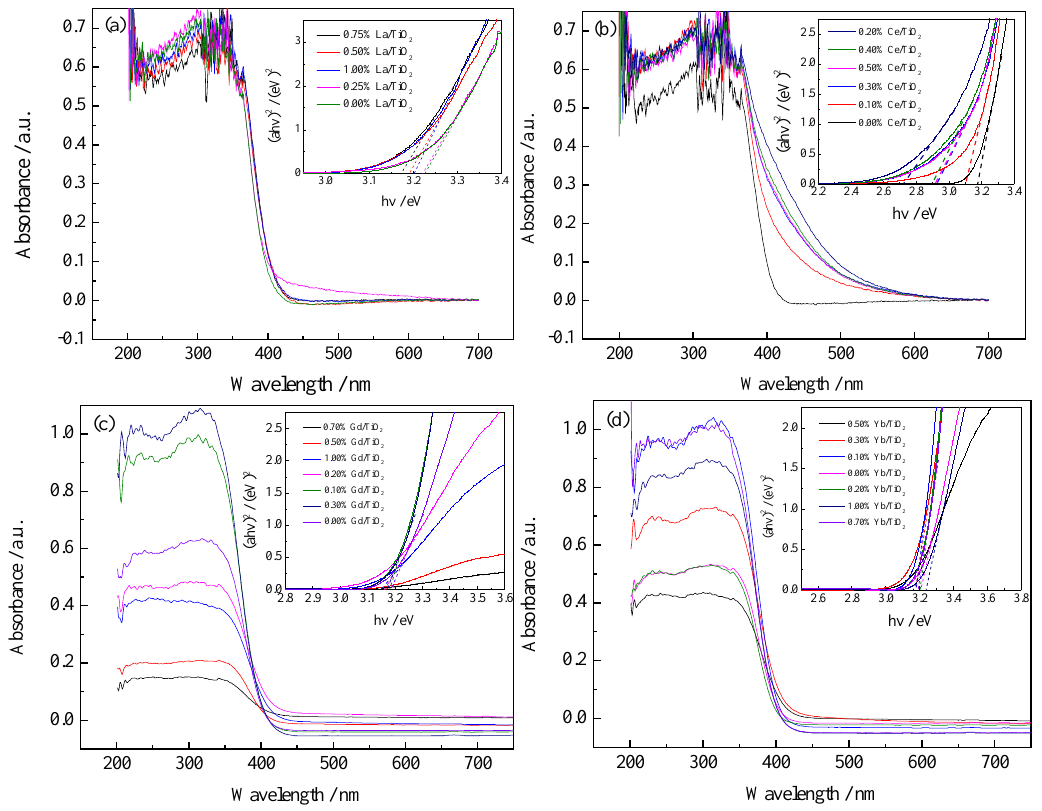
Figure 3. UV-Vis DRS patterns of RE/TiO 2 with different rare-earth doping ratios. ( a ) La/TiO 2 ; ( b ) Ce/TiO 2 ; ( c ) Gd/TiO 2 ; ( d ) Yb/TiO 2 .